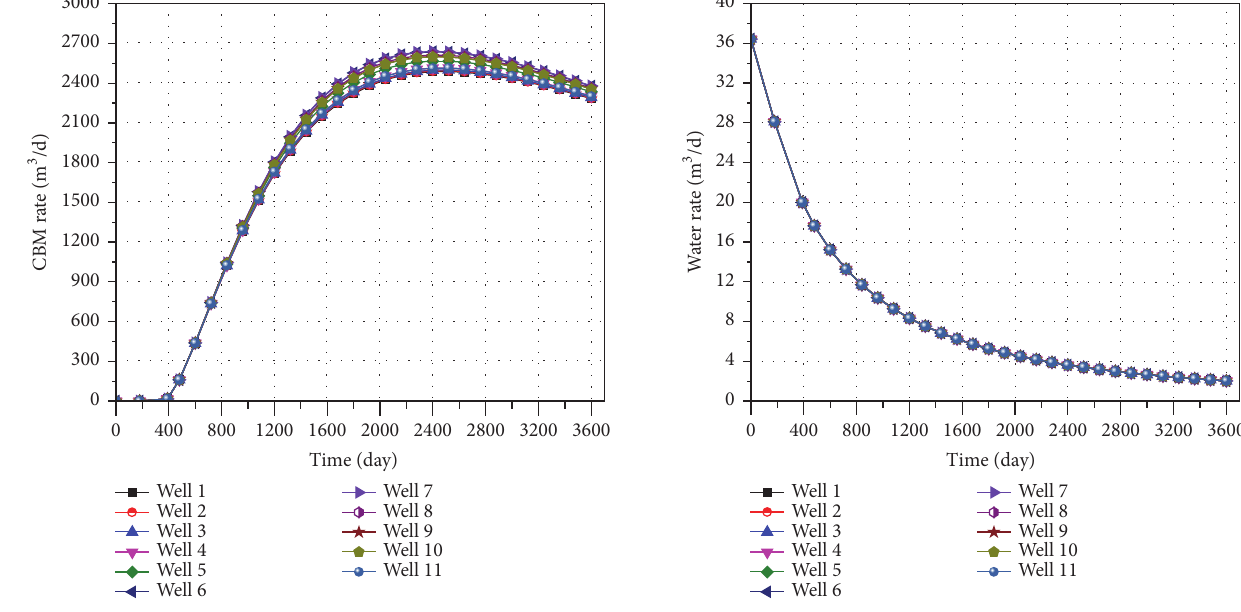
Figure 11: Daily well gas productions. Figure 12: Daily well water